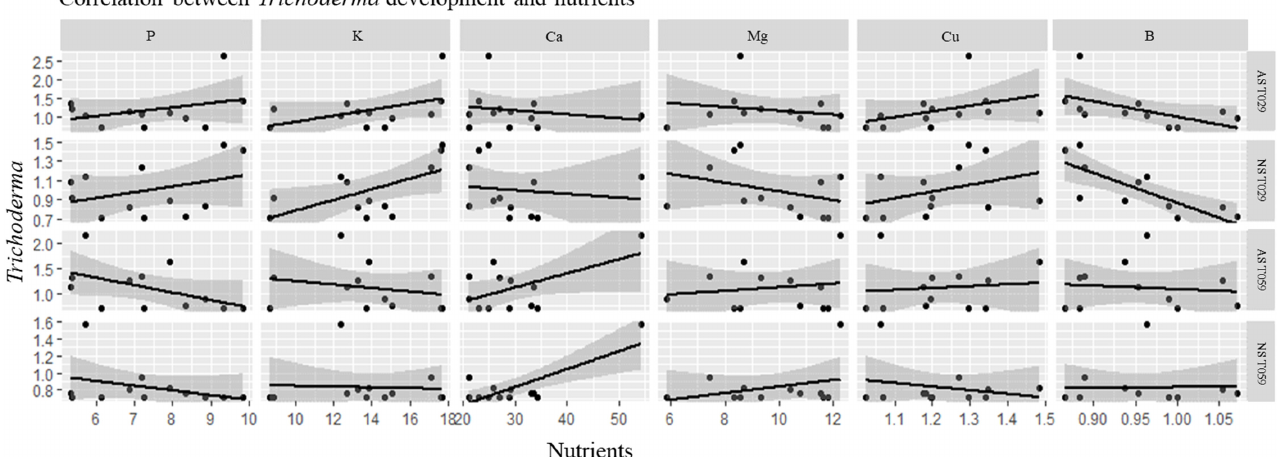
Figure 5. Correlation values of the Canonical Correlation Analysis (CCA) between Trichoderma spp. and nutrients. Natural soil T. harzianum (NS T059), natural soil T. velutinum (NS T029), autoclaved soil T. harzianum (AS T059). autoclaved soil T. velutinum (AS T029). Assimilable phosphorus (P), the cations potassium (K), calcium (Ca), magnesium (Mg), copper (Cu) and boron (B).